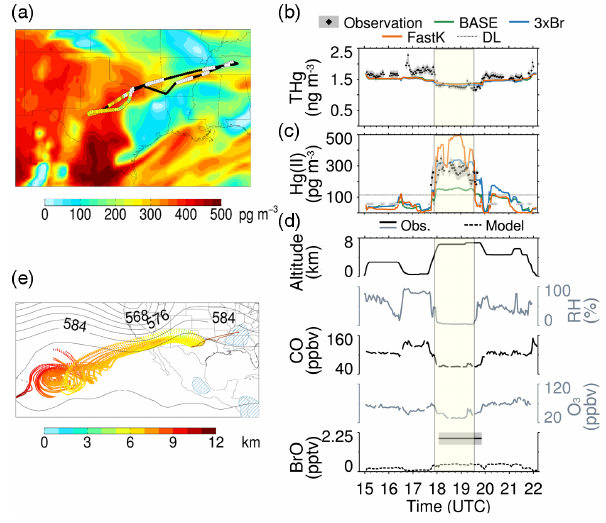
Figure 6. Case study for RF-06 on 19 June 2013. (a) The C-130 flight track with circles color-coded based on observed Hg(II) con- centrations (locations along the flight track with no Hg(II) observa- tions are filled in black, and below the detection limit (BDL) ob- servations are filled in white). The background map displays the GEOS-Chem Hg(II) concentrations at 450hPa for the 3 × Br sim- ulation between 17:00–20:00UTC. The time series of the observa- tions of THg and Hg(II) are shown in panels (b, c) . The THg and Hg(II) measurements are represented by filled diamonds with the uncertainty represented by the gray shading. The dashed line repre- sents the DL, and BDL observations are plotted at DL/2 with open circles. Modeled concentrations of THg and Hg(II) are displayed for the BASE (green line), 3 × Br (blue), and FastK (orange) sim- ulations. Flight times where high Hg(II) concentrations were ob- served are highlighted. The time series of flight altitude, RH, CO, O 3 , and BrO (observations and model) are shown in panel (d) . Panel (e) shows the 7-day HYSPLIT back trajectories for the high- lighted sections of the flight. The contours show the NCEP/NCAR Reanalysis 500hPa geopotential heights on 18Z for the day of the flight. The hatched areas show regions with greater than an average of 10mmday − 1 of surface precipitation for 7days before the flight.